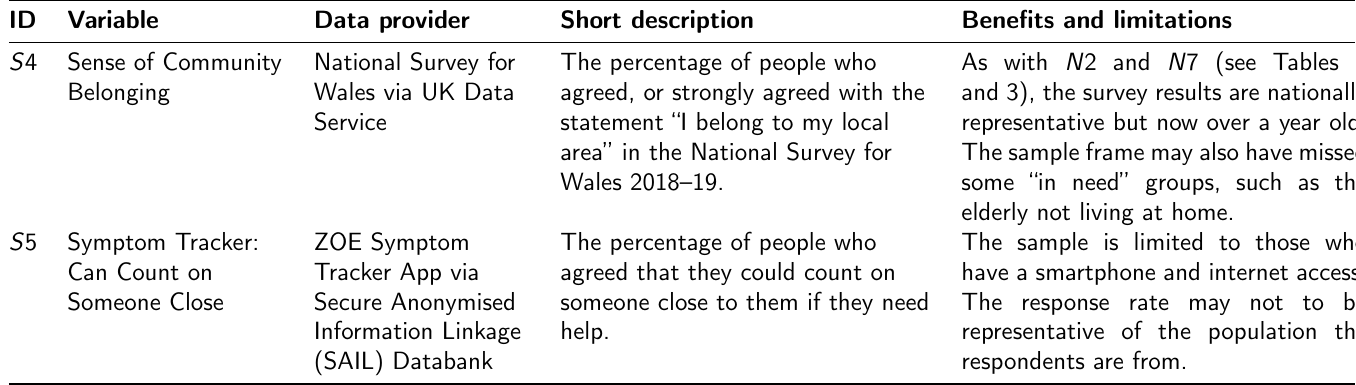
Table 5: Summary description of variables included in the community cohesion dataset